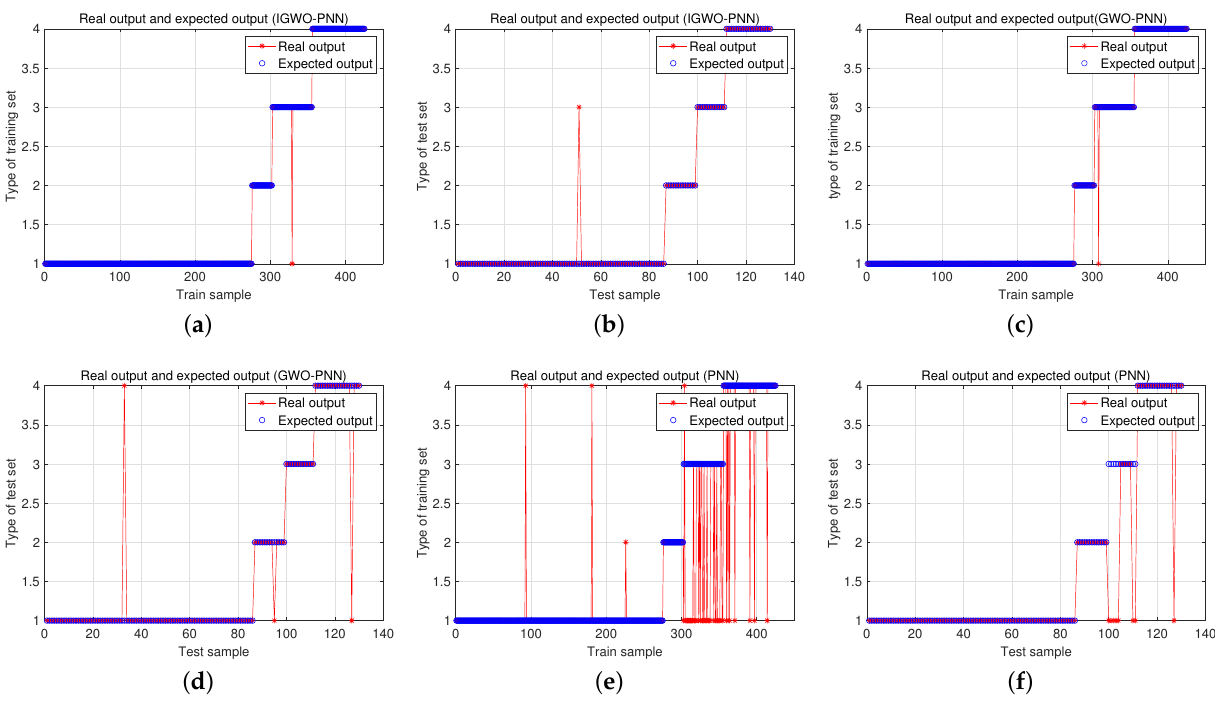
Figure 6. Comparison of the diagnosis results of the first set of comparative experiments. ( a , c , e ) represent the results of